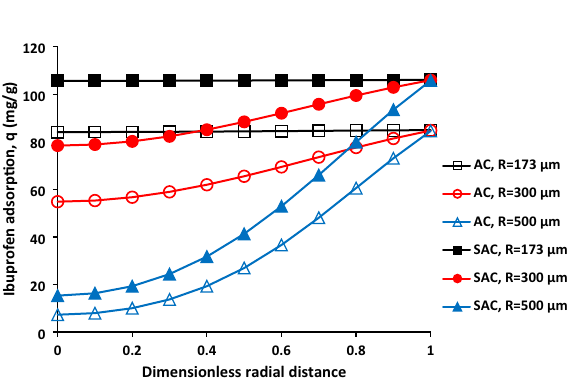
Figure 4. Effect of particle diameter on the ibuprofen adsorption for AC ( a ) and SAC ( b ), initial ibuprofen concentration = 100 mg/L, T = 298 K, pH = 2, AC porosity = 0.392, SAC porosity = 0.474, and adsorbent dosage of 0.5 g/L.